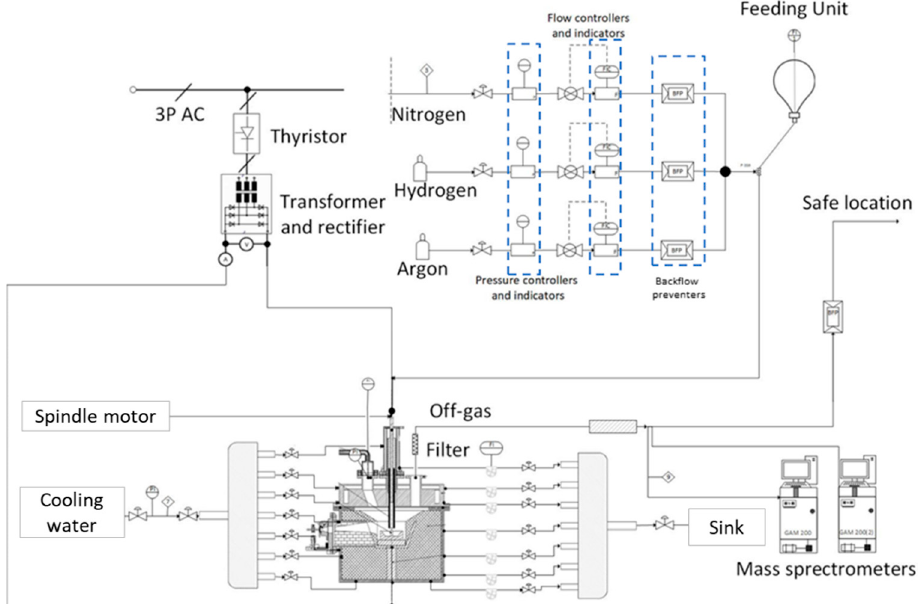
Figure 4. Layout of the HPSR laboratory facilities at the Chair of Ferrous Metallurgy. Table 2. Design of experiments of the trials at the HPSR laboratory